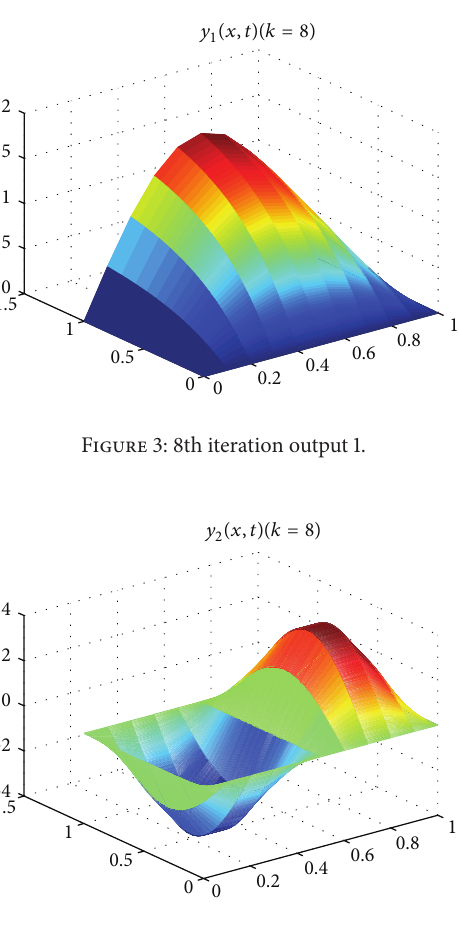
Figure 4: 8th iteration output 2.